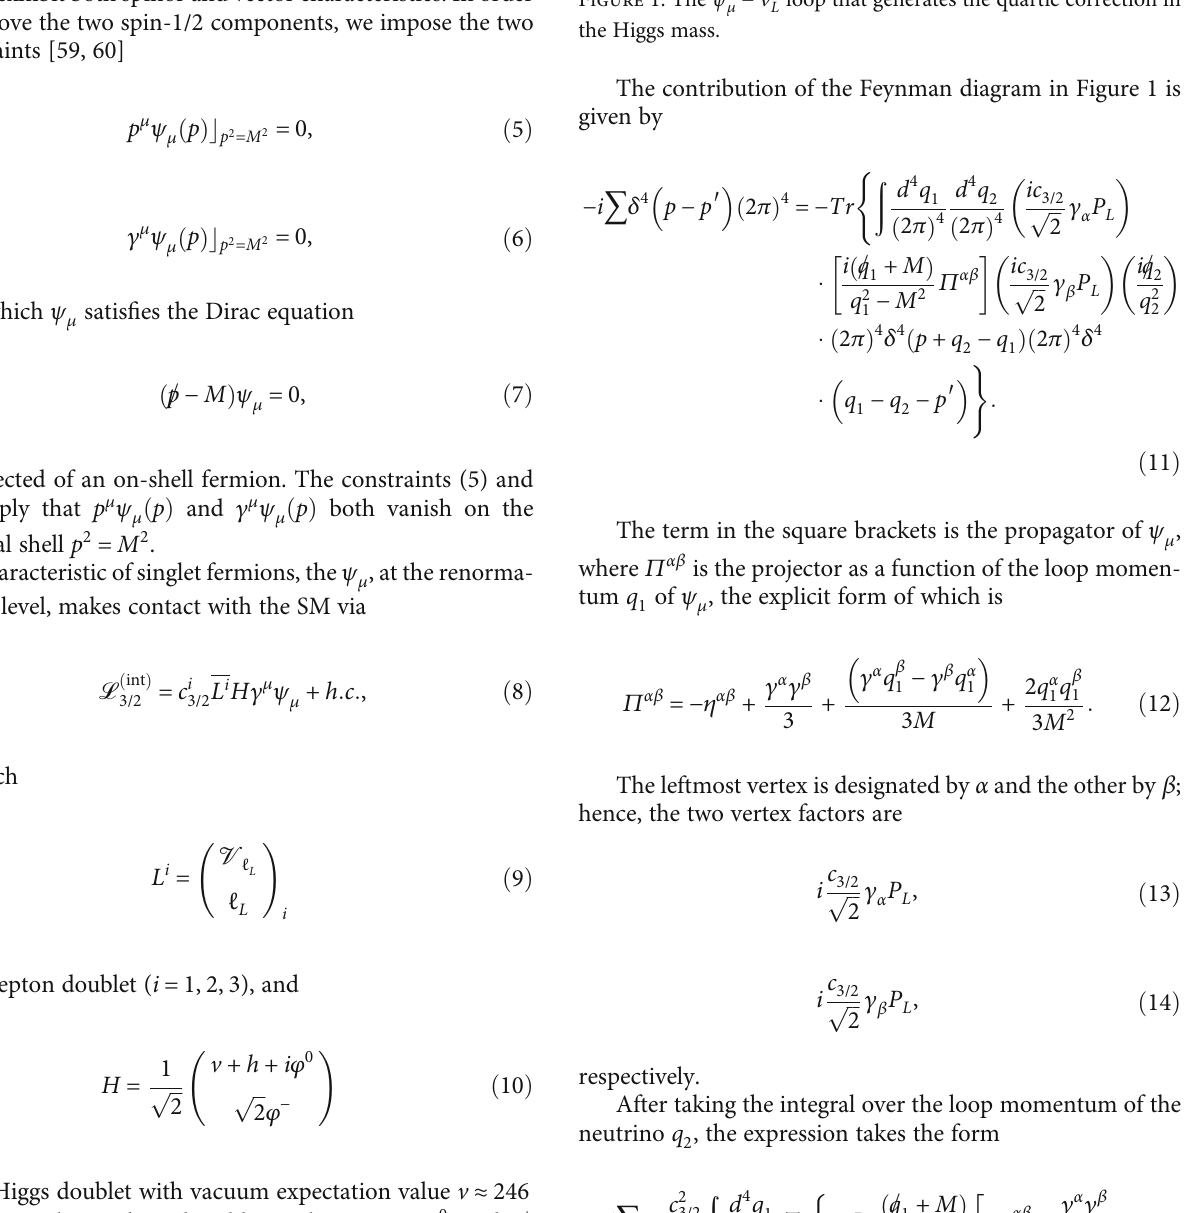
− ν loop that generates the quartic correction in μ L